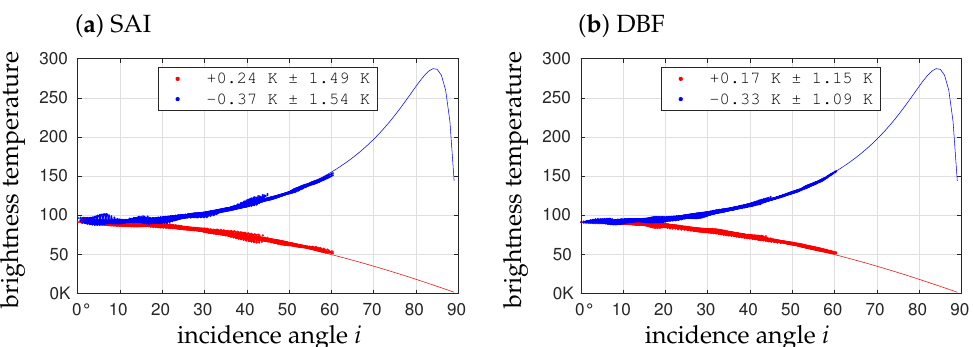
Figure 9. Variations of the retrieved temperatures T H r (red dots) and T V r (blue dots) as well as those of the temperatures T H (red line) and T V (blue line) of the scene with the ground incidence angle i ( a ) for the SAI paradigm and ( b ) for the DBF one. Biases and standard deviations are those in the EAF-FOV of Figure 8.